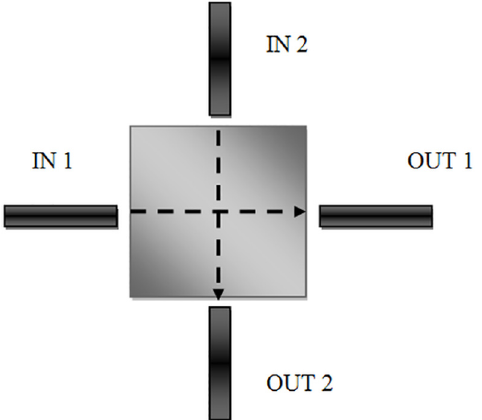
Fig 2. Current distributions of the orthogonal modes in the basic square